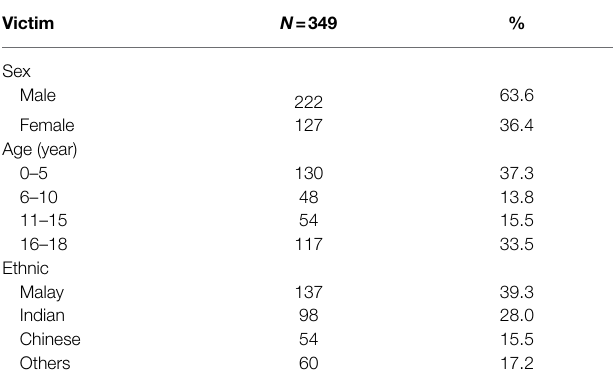
TABLE 2 | Background of child homicide victims in Malaysia from January 2010 to June